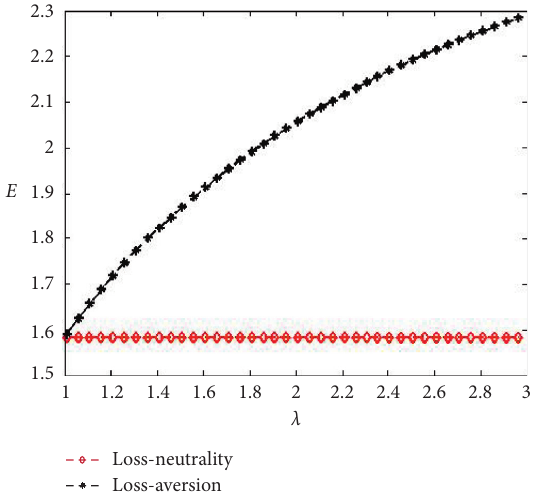
Figure 12: Effect of λ on environment ( N � 6 and R �